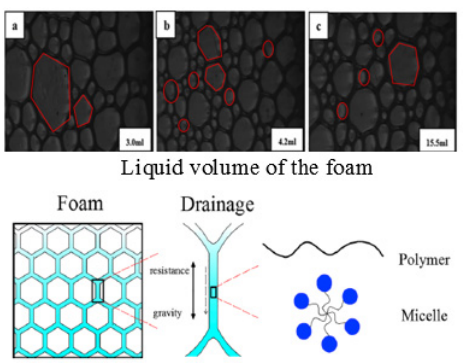
Figure 12. Foam-drainage behavior of the surfactant solution with added polymer [71].